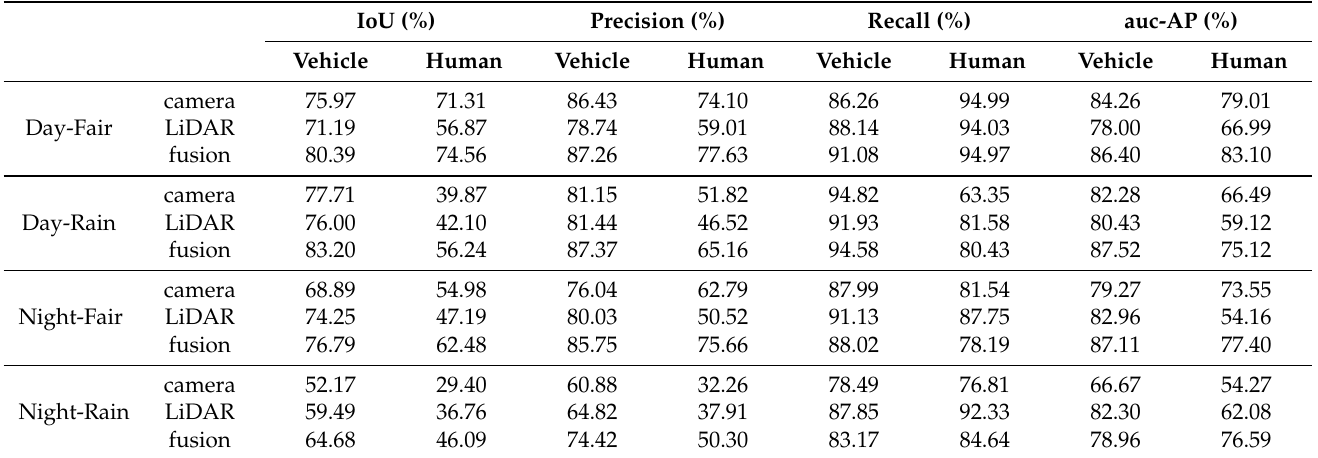
Table 5. Performance of the supervised learning iseAuto baseline